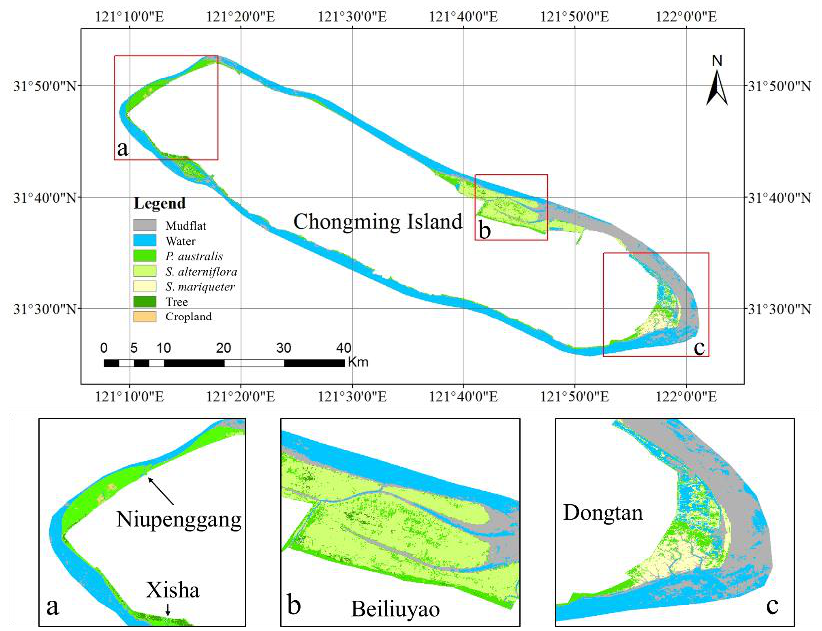
Figure 11. Classification results from the feature collection constructed by Tian et al. Subfigure ( a ) shows the Xisha and Niupenggang areas, subfigure ( b ) shows the Beiliuyao area, and subfigure ( c ) shows the Dongtan area.